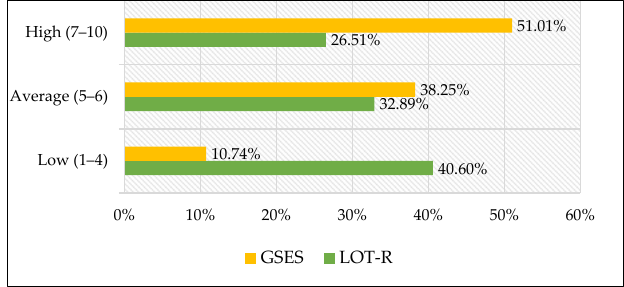
Figure 1. The structure of the results for self-efficacy and dispositional optimism on the sten scale.